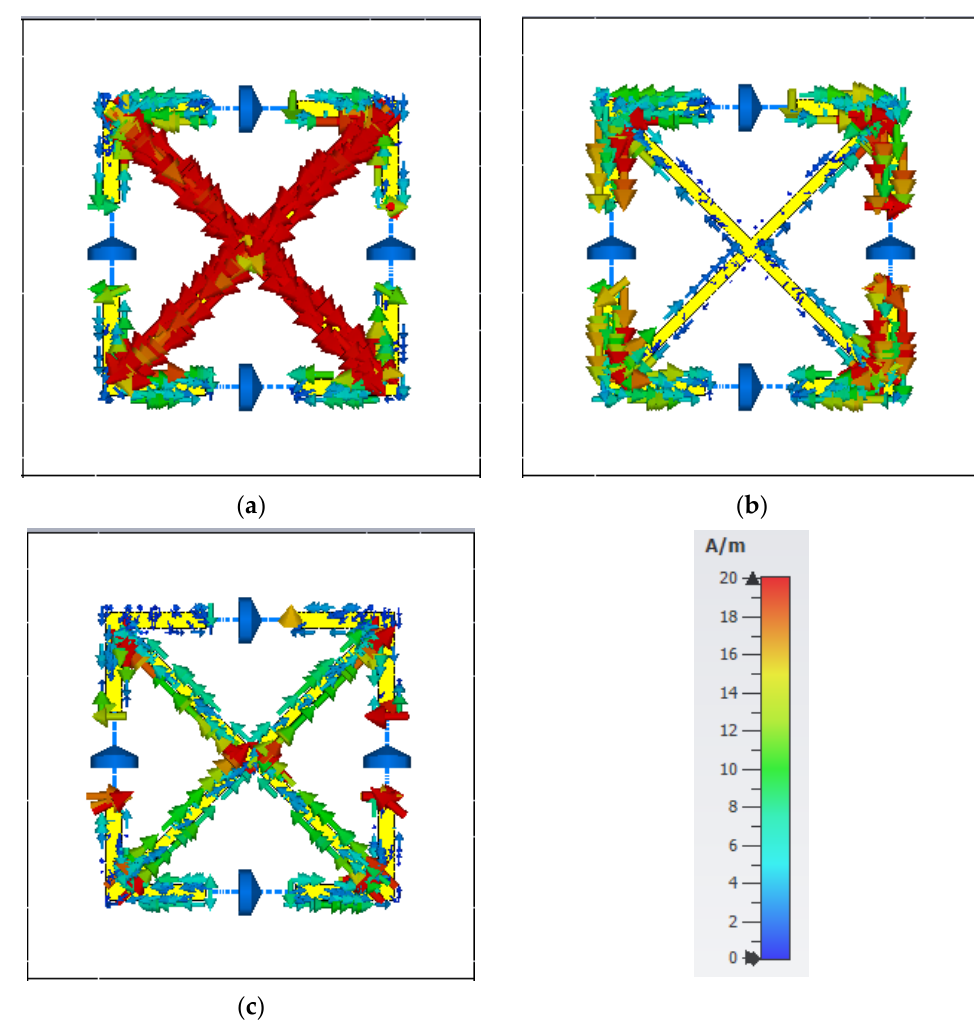
Figure 5. Surface current distributions: ( a ) 2.09 GHz, ( b ) 4.34 GHz, and ( c ) 6.2 GHz.